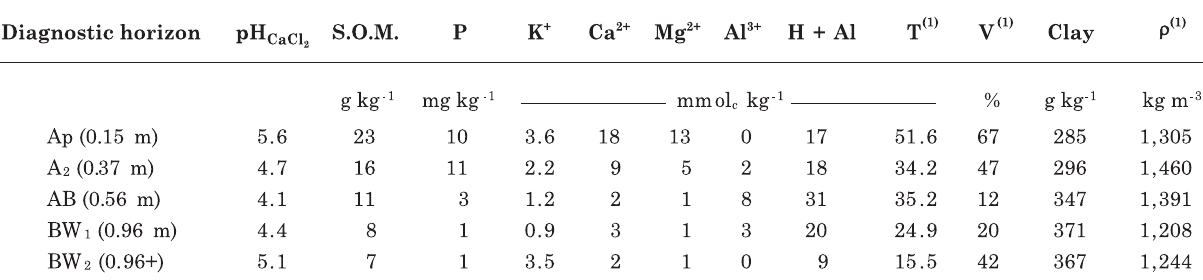
Table 1. Chemical and physical characterization of the Arenic Kandiustults (Latossolo Vermelho distrófico